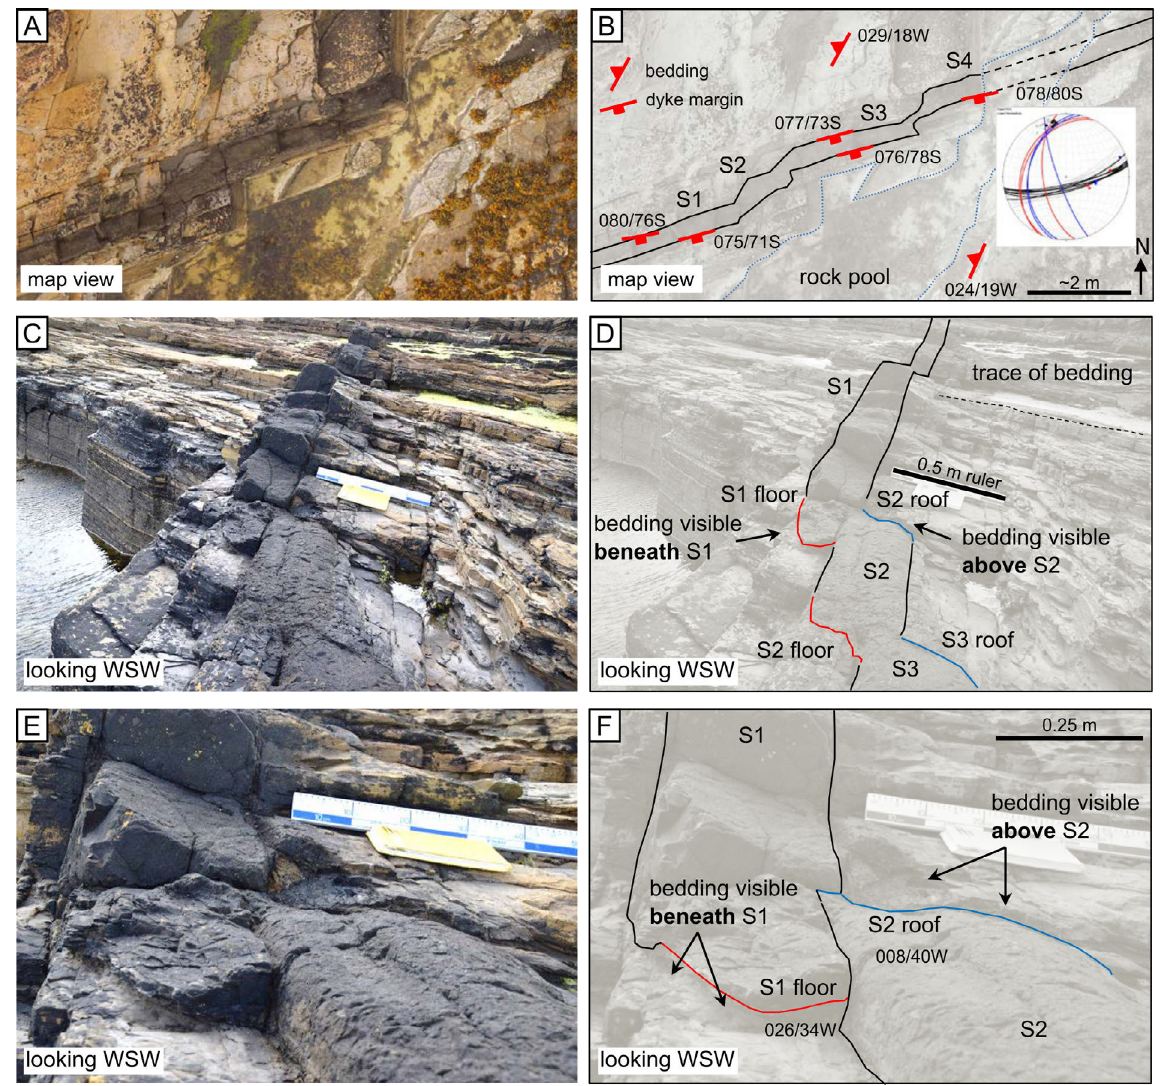
Figure 7: Field observations from Relay B on Dyke 1. [A]–[B] Photograph and interpretation in map view of four segments S1–S4. The inset stereogram in [B] shows the orientations of the dyke margins (black) and the interpreted floor and roof tip-lines (red and blue, respectively). [C]–[D] Photograph and interpretation of the relationship between S1 and S2, looking WSW. Bedding in the host rock is seen beneath S1 and above S2, these contacts are taken as a floor and a roof respectively. Bedding is again visible beneath the easternmost end of S2, and this contact is also interpreted as a segment floor. [E]–[F] Close-up photograph and interpretation of the S1 floor and S2 roof geometry shown in [C]–[D]. The measured orientations of these contacts are shown in the stereogram inset in [B]. Note again the gently domed appearance of the exposed top (roof) of S2, contrasted with the flat, bedding parallel base (floor) of